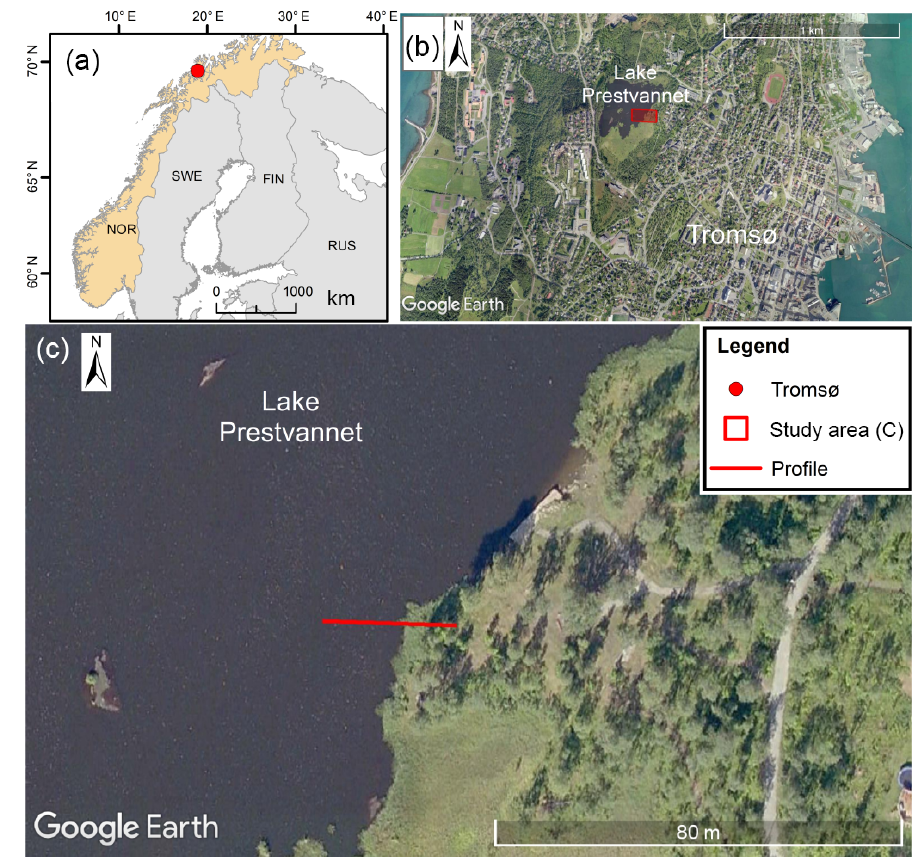
Figure 3. Geographical maps of Lake Prestvannet. The location in the northern part of Norway is shown in part (a) by the red dot. The lake is located on the peninsula Tromsøya, presented in panel (b) , close to the city Tromsø (© Google Earth). A detailed view of the test site is given in panel (c) , showing the profile crossing the boundary from the lake to the shore (© Google